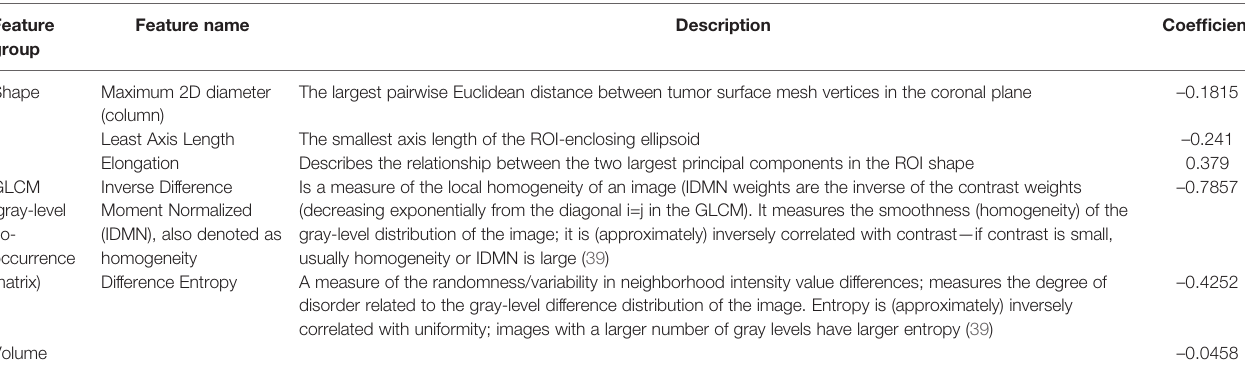
TABLE 1 | List of the features selected and included in the radiomic signature. Mean values of the coef fi cients of the Elastic Net logistic regression (averaged over 500 model